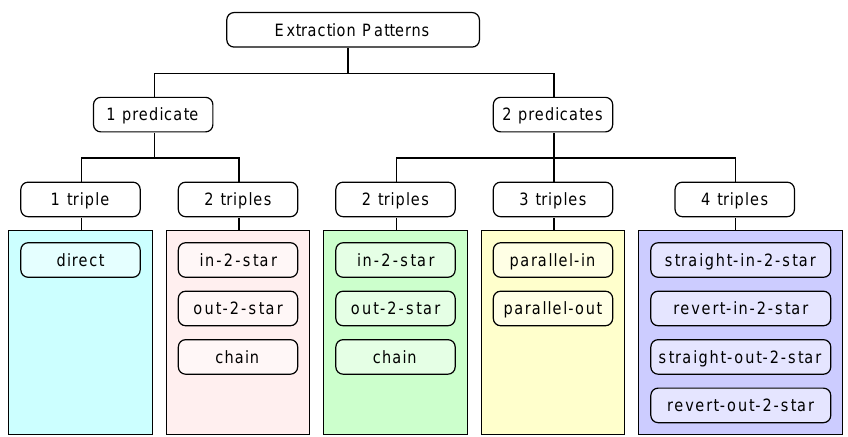
Figure 7. Classification of extraction patterns.